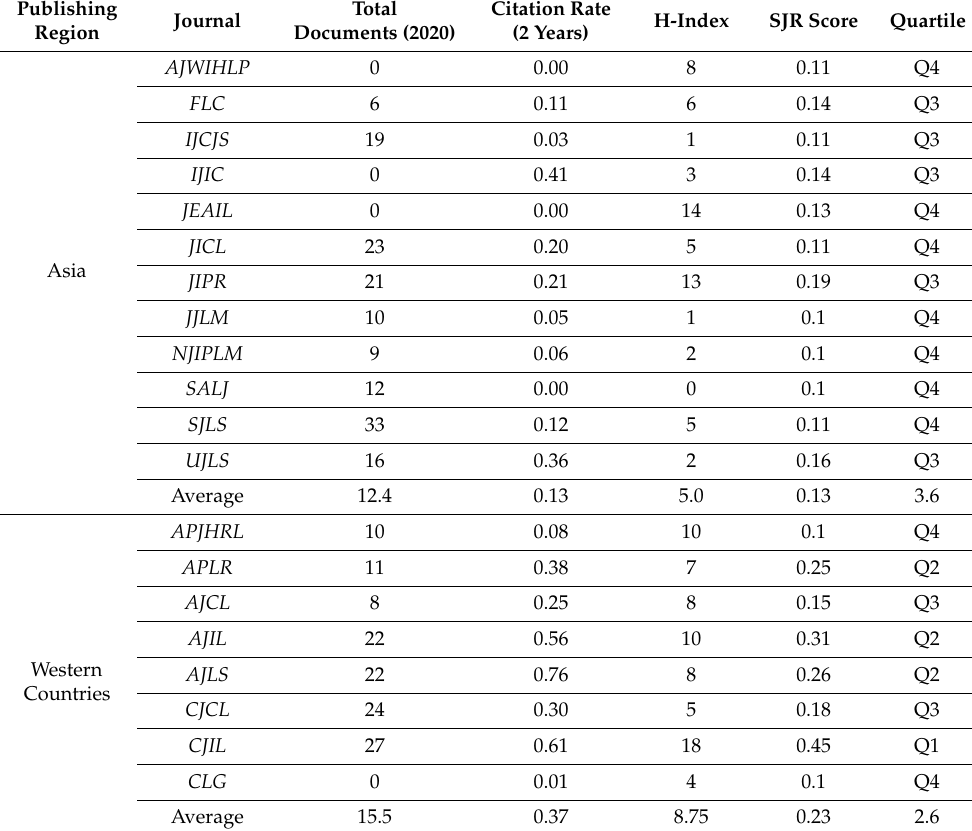
Table 4. Performance Measurements of Asian Law Journals.